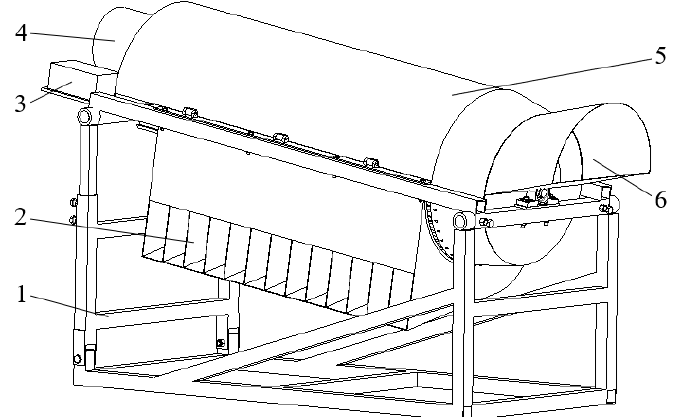
Figure 1. Longitudinal axial fl ow pod-picking device: 1—angle-adjusting base; 2—feeding outlet; 3—speed regulator; 4—speed regulating motor; 5—pod-picking system; 6—feeding inlet.